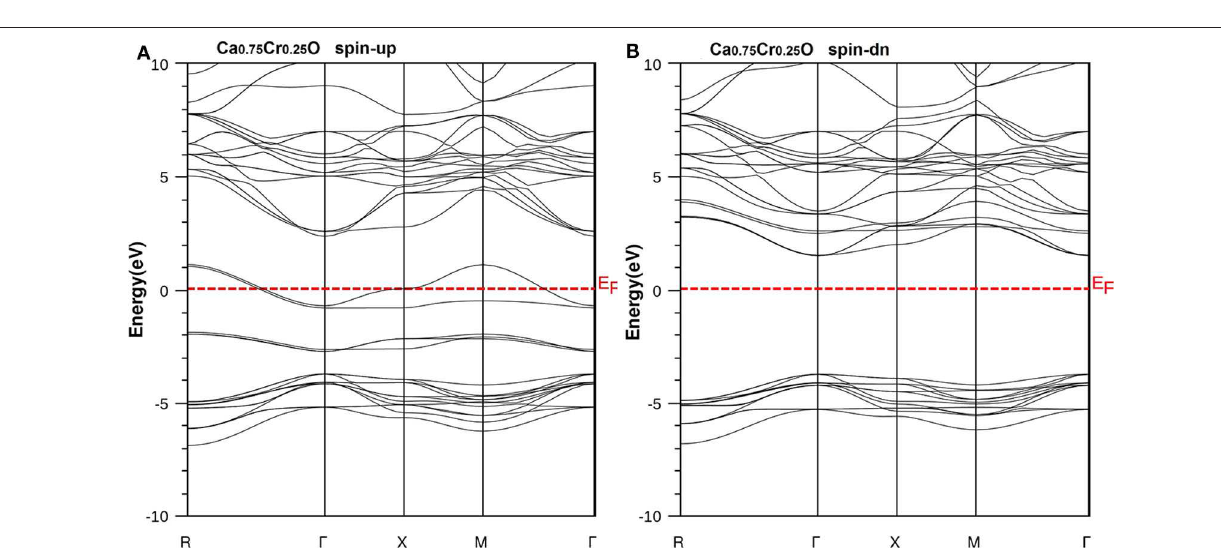
3.437 to 3.67 eV of Fan et al. (2015), Nejatipour and Dadsetani (2015), Yang et al. (2016), Tran and Blaha (2017), Salam (2018) found by the LDA (Perdew and Zunger, 1981; Perdew and Wang, 1992), GGA-WC (Wu and Cohen, 2006), GGA-PBE (Perdew et al., 1996), and GGA-PBEsol exchange potentials (Perdew et al., 2008). The TB-mBJ provides accurate gap for CaO because he is known for its performance in the calculation of electronic structures of insulators and semiconductors with respect to LDA and all forms of GGA approximations (Bhattacharjee